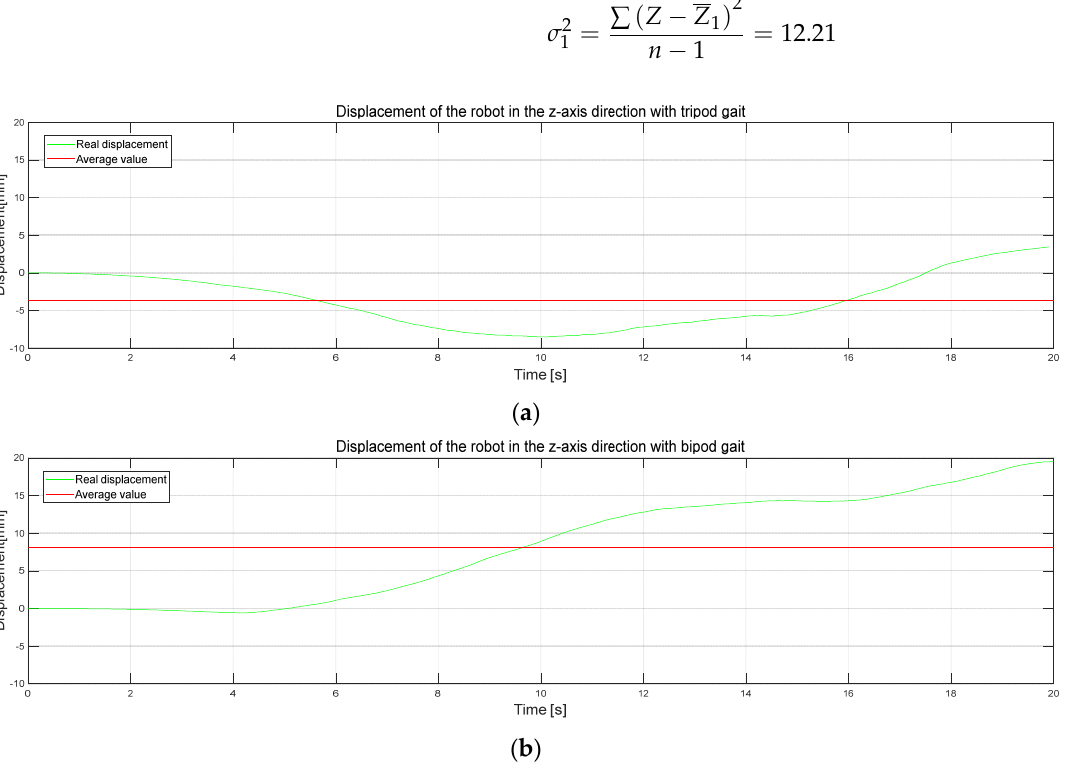
Figure 19. Plot of the actual and average displacements of the robot in the Z − axis direction for different gaits. ( a ) The displacement variation on the Z − axis when the robot advances with a tripod gait. ( b ) The displacement variation on the Z − axis when the robot advances with a bipod gait.